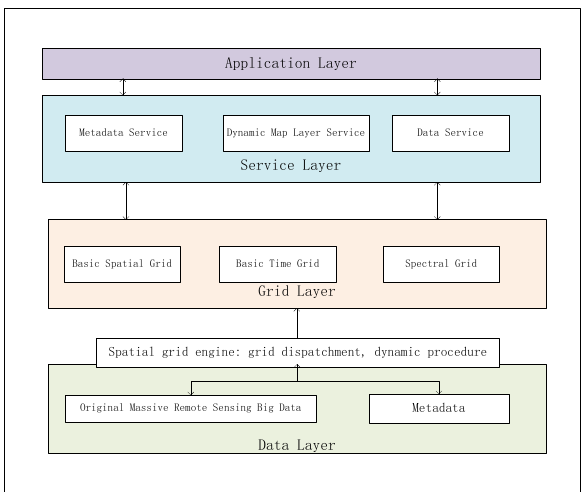
Figure 2. Data organization model based on an extensible discrete global grid